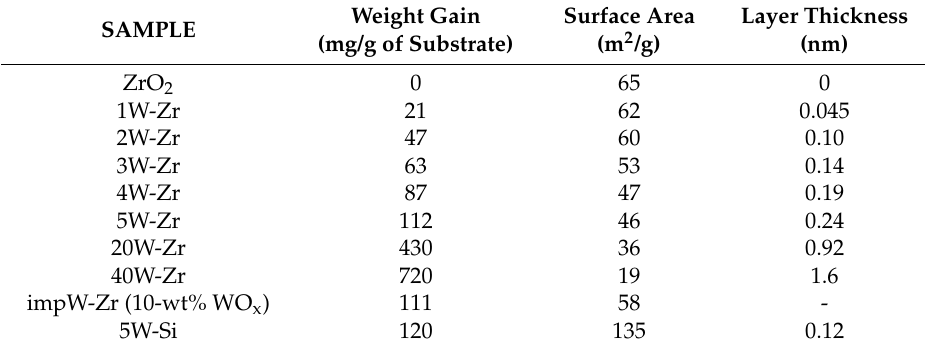
Figure 1. XRD patterns for (a) ZrO 2 , (b) 5W-Zr (5 ALD cycles), and (c) 40W-Zr (40 ALD cycles). Monoclinic phase ( ■ ); tetragonal phase ( ♦ ). Table 1. Weight gain, surface area, and calculated layer thickness for W-Zr and W-Si materials. The layer thickness was calculated using a WO 3 density of 7.16 g/cm 3 . The nomenclature x W-Zr is used to refer to a sample exposed to x ALD cycles.